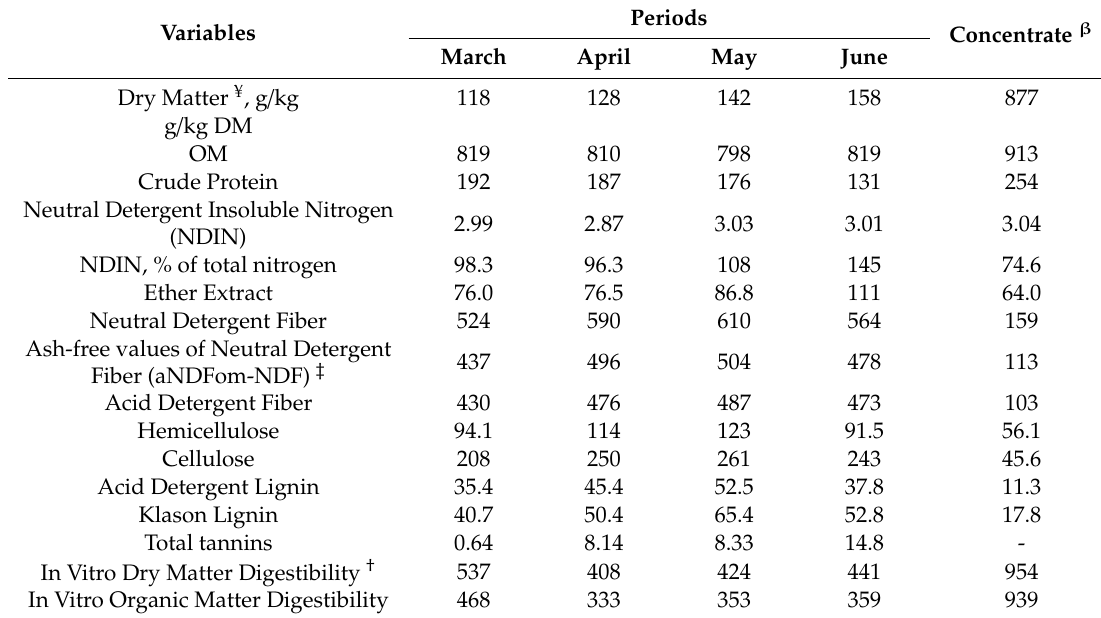
Table 2. Composition of ruminal extrusa samples † collected from sheep on Caatinga -native pasture during the rainy